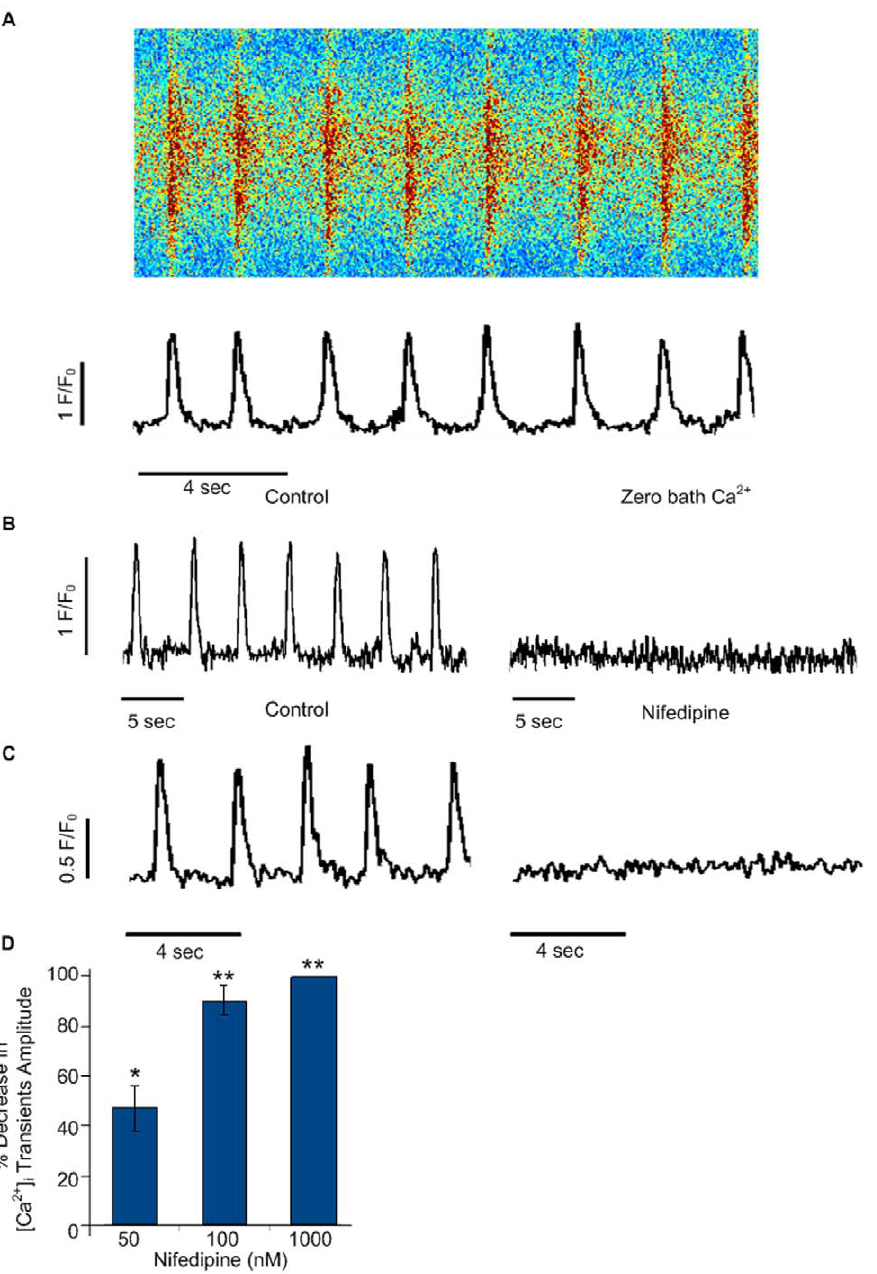
cell [Ca 2 + ] i transients are displayed either as a distance-time plot (upper panel) or as a line-scan tracing (lower panel). ( B ) Whole-cell [Ca 2 + ] i transients in the presence (left) and absence (right) of bath Ca 2 + . ( C ) Whole-cell [Ca 2 + ] i transients before (left) and after (right) application of nifedipine (1 m M). ( D ) Dose-response curve showing the percentage of decrease in [Ca 2 + ] i transients amplitude relative to baseline conditions as function of nifedipine concentration (0.05, 0.1 and 1 m M, n=6). *p , 0.05 and **p , 0.01 when mean absolute values were compared to baseline values. Abbreviations: F/Fo, fluorescence (F) normalized to baseline fluorescence (Fo); sec, seconds.